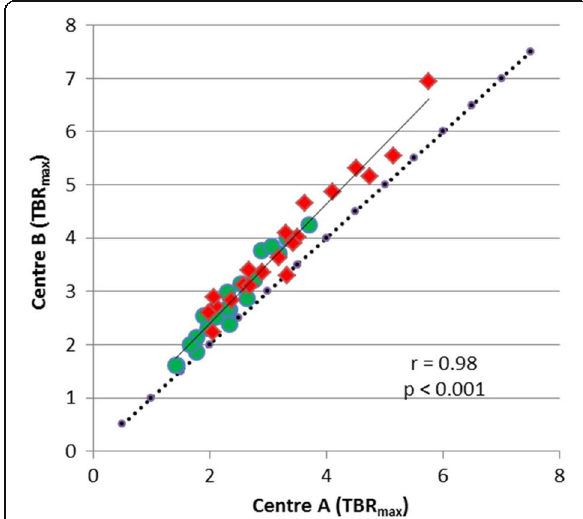
Fig. 5 Correlation of TBR mean from centres A and B . There is a significant correlation which is close to the line of unity. High-grade tumours are indicated by red symbols and low-grade tumour by green symbols